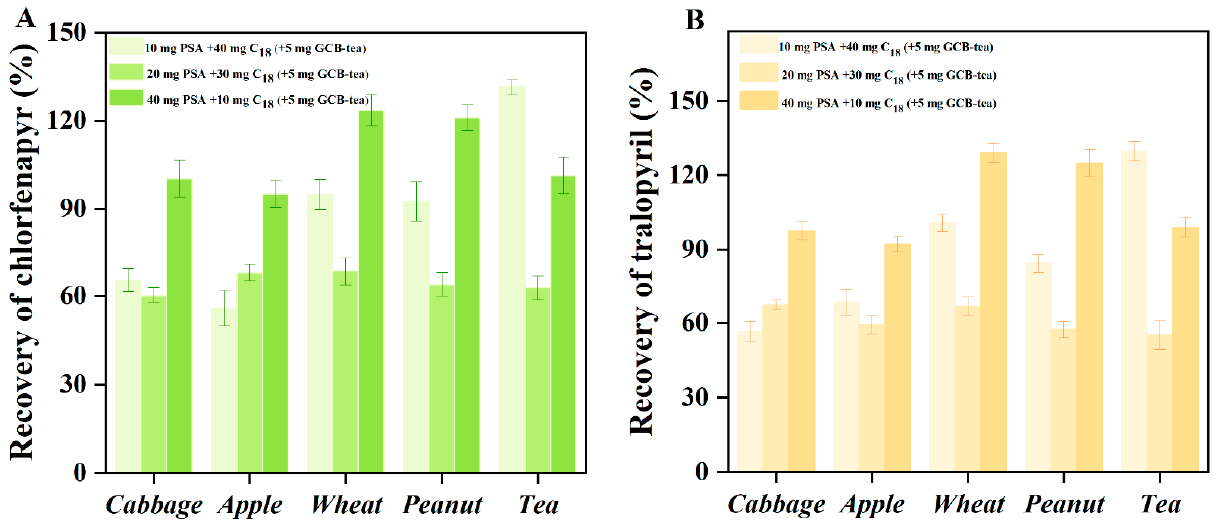
Figure 1. Recoveries of chlorfenapyr ( A ) and tralopyril ( B ) in 5 representative samples under different purification combinations. Note: Five replicates with each treatment. The spiked concentration of samples was 0.01 mg kg − 1 .